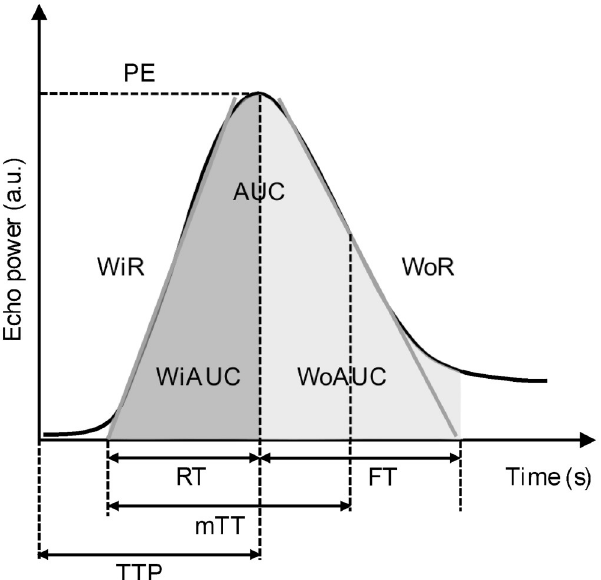
Fig 3. Schematic representation of a time intensity curve of the kidney. The x-axis represents the time in seconds (s) and the y-axis represents the intensity in arbitrary units (a.u.). Intensity-related parameters are as follows: peak enhancement (PE) referring to maximum enhancement; wash-in area under the curve (WiAUC) and wash-out area under the curve (WoAUC) referring to the sum of all amplitudes inside the range from the beginning of the curve up to the time-to-peak (TTP) and from the TTP to the end of the descending curve, respectively; and total area under the curve (AUC)). Time-related parameters are as follows: rise time (RT) referring to the time interval between the first arrival of contrast and TTP; mean transit time (mTT) representing the mean duration of complete contrast perfusion, refers to the time when the tissue begins to enhance with contrast medium until the enhancement is half of the PE; TTP referring to the time of contrast agent injection to maximum enhancement; fall time (FT) referring to the duration of contrast wash-out) were determined from the time intensity curves. The slopes of the time-intensity curve are wash-in (WiR) and wash-out rate (WoR) referring to the maximum and minimum slopes, respectively. Wash-in perfusion index (WiPI) is calculated as WiAUC divided by RT. Adapted from the VueBox user manual with permission